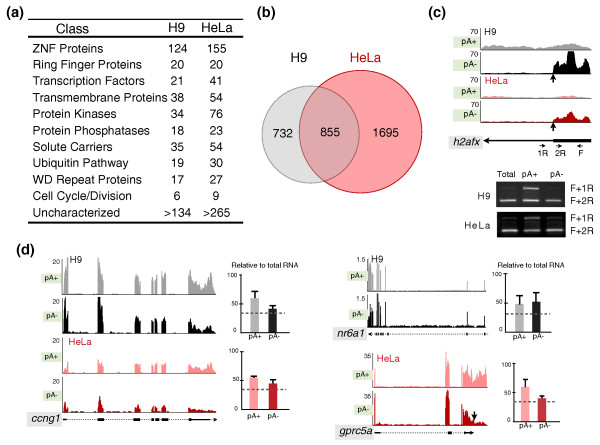
Classification of bimorphic transcripts. (a) Gene ontology analysis of bimorphic transcripts according to their functions; see text for details. (b) Overlapping analysis of the expression of bimorphic transcripts in H9 and HeLa cells. (c) An example of a bimorphic histone mRNA, hist1h2afx. Normalized read densities of hist1h2afx from the UCSC genome browser (upper panels). Note that the two isoforms were distinct in poly(A)+ and poly(A)- samples from H9 and HeLa cells. Bottom panels, semi-quantitative RT-PCR with primers that recognize either the longer poly(A)+ transcript or both transcripts confirmed the observations from the deep sequencing. F, forward primer; 1R and 2R, reverse primers. The vertical arrow depicts the position of U7-mediated 3' end formation. (d) Validation of identified bimorphic transcripts, ccng1(left panels), nr6a1 (right upper panels) and gprc5a (right bottom panels). Normalized read densities and qRT-PCRs were analyzed as described above. Note that the signals for these transcripts were similar in both poly(A)+ and poly(A)-samples. See text for details. Error bars were calculated from three biological repeats.